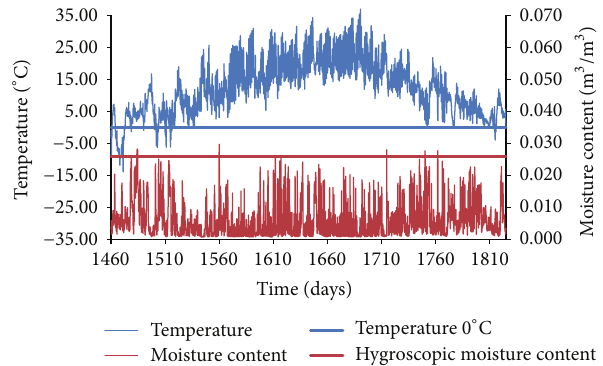
Figure15:Temperatureandmoisturecontentversustimefunctions, SZ sandstone, Holeˇsov.